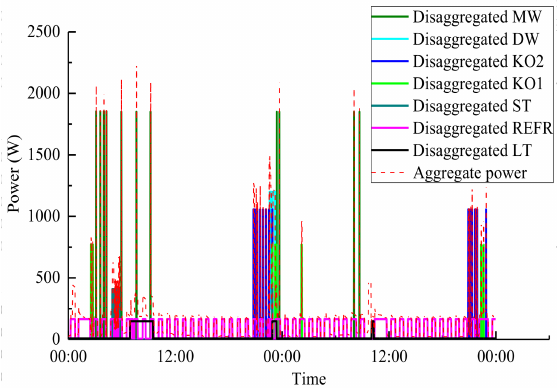
Figure 2. Disaggregation result in House 2 for two days.